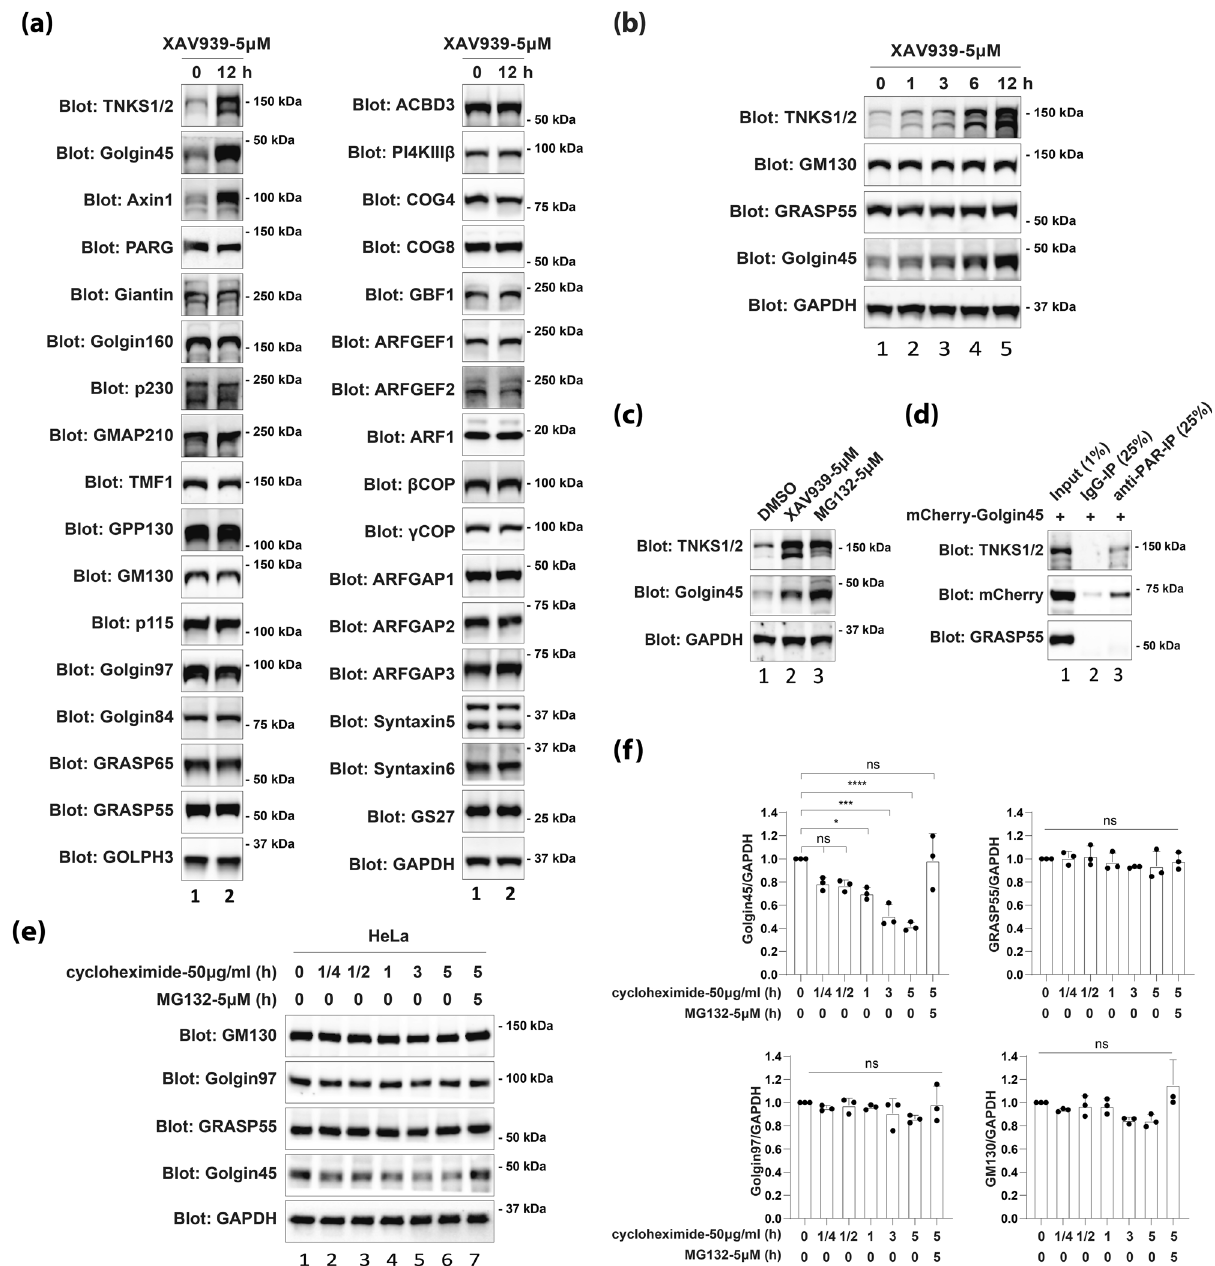
Fig. 2 TNKS1 selectively regulates Golgin45 protein level by PARylation and subsequent proteasome-dependent degradation pathway. a TNKS1- dependent regulation is highly restricted to Golgin45 among Golgi-associated proteins. Western blots showing chemical inhibition of TNKS1 activity by XAV939 in HeLa cells for 12 h results in selective up-regulation of Golgin45 and TNKS1 protein level among the 30 Golgi-associated proteins tested here. Representative blots are shown and experiments were repeated two times. b Inhibition of TNKS1 activity results in a time-dependent increase of Golgin45 and TNKS1 protein level. HeLa cells were treated with XAV939 for the indicated times and lysed for analysis of endogenous proteins by SDS-PAGE and western blot analysis. Note that protein level of GM130, GRASP55, and GAPDH shows no signi fi cant change by XAV939 treatment. c Inhibition of proteasome and TNKS1 activity stabilizes Golgin45 and TNKS1 protein to a similar extent. HeLa cells were treated with either DMSO (control) or MG132 or XAV939 for 12 h, followed by lysis and western blotting with the indicated antibodies. Representative blots are shown and experiments were repeated three times. d anti-PAR IP from HeLa cells expressing mCherry-Golgin45 pulls down mCherry-Golgin45 and TNKS1/2 (positive control), but not GRASP55 (negative control). The protein extracts from HeLa cells expressing mCherry-Golgin45 were immunoprecipitated with anti-PAR or normal mouse IgG. These lysates and the immunoprecipitates were analyzed by western blotting using antibodies against the indicated proteins. Representative blots are shown and experiments were repeated three times. e Golgin45 protein half-life is very short, compared to other Golgi structural proteins. HeLa cells were treated with 50 μ g/ml cycloheximide and MG132 for the indicated times. Endogenous GM130, Golgin97, GRASP55, Golgin45 and GAPDH were monitored by immunoblotting. f Quanti fi cation of endogenous GM130, Golgin97, GRASP55 and Golgin45 protein levels relative to GAPDH expression is shown. Statistical analysis was performed using one-way ANOVA with a Tukey ’ s post-hoc test (mean ± SD; n.s., not signi fi cant; *, p < 0.05; ***, p < 0.001; ****, p <